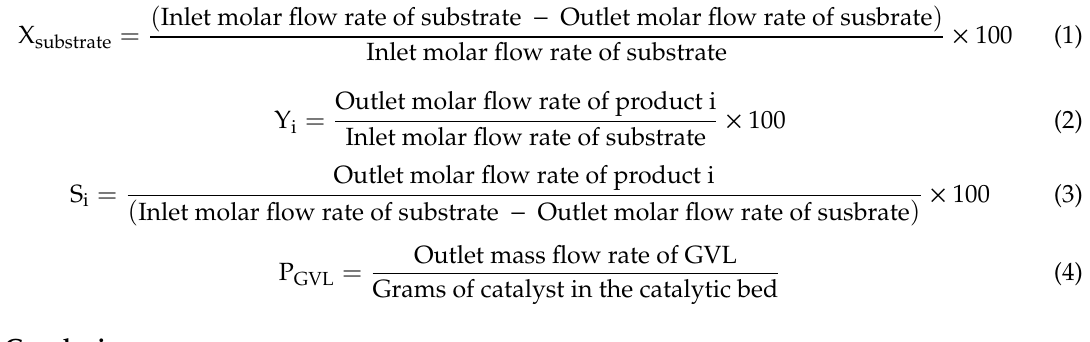
Figure S1: DRIFT signals of adsorbed pyridine on parent (commercial) Beta and Zr–Al-Beta zeolites. Figure S2: NH3-TPD profiles of commercial of commercial H-Beta parent zeolite and Zr–Al-Beta zeolite. Figure S3: Ar adsorption–desorption isotherms of commercial H-Beta zeolite and Zr–Al-Beta (left side). Pore sizes distribution of commercial H-Beta parent zeolite and Zr–Al-Beta (right side). Figure S4: XRD patterns of Zr–Al-Beta, as compared to commercial Beta zeolite and crystalline ZrO2 (monoclinic